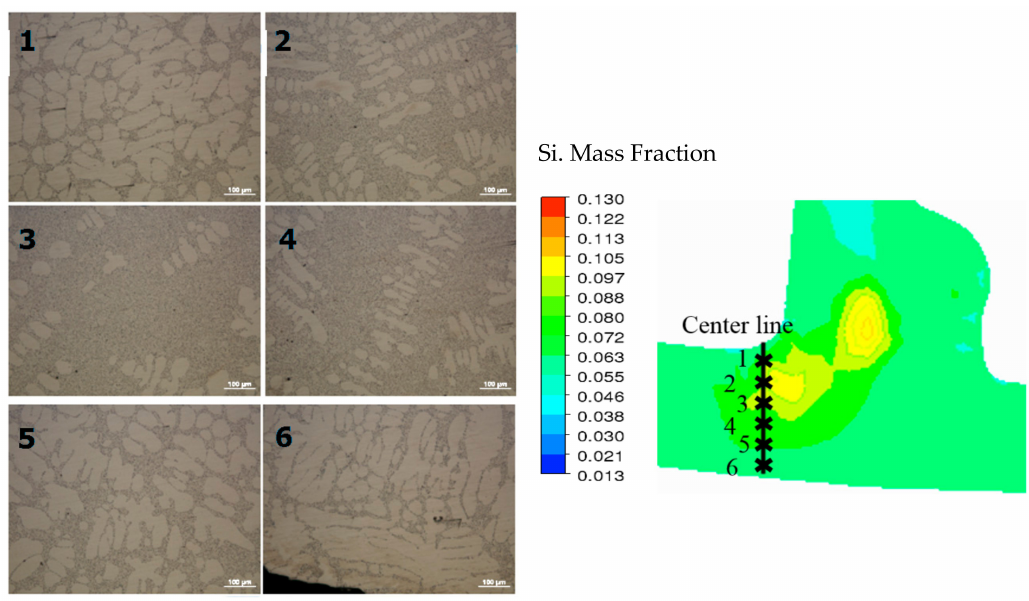
Figure 6. Microstructure along the center line in the wheel ( left ) and the location on the wheel where the comparison was made ( right ). Note: number appearing in the photomicrograph corresponds to location indicated in adjacent figure wheel section.